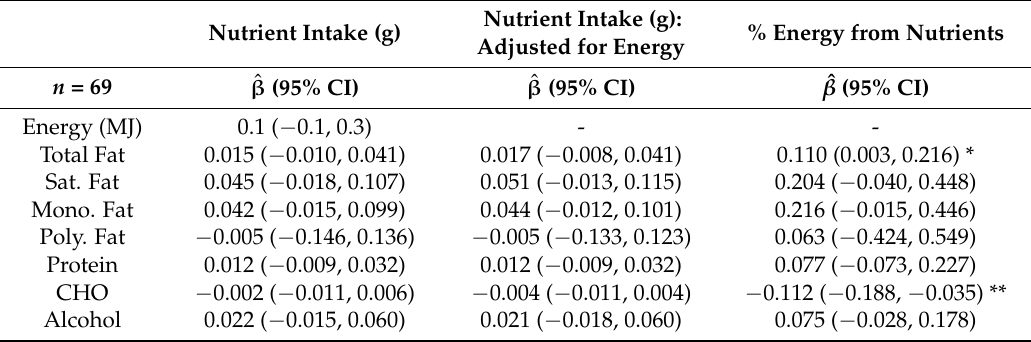
Table 4. Associations between fat taste (FT) rank, energy, and macronutrient intakes from the 24-h food recall.